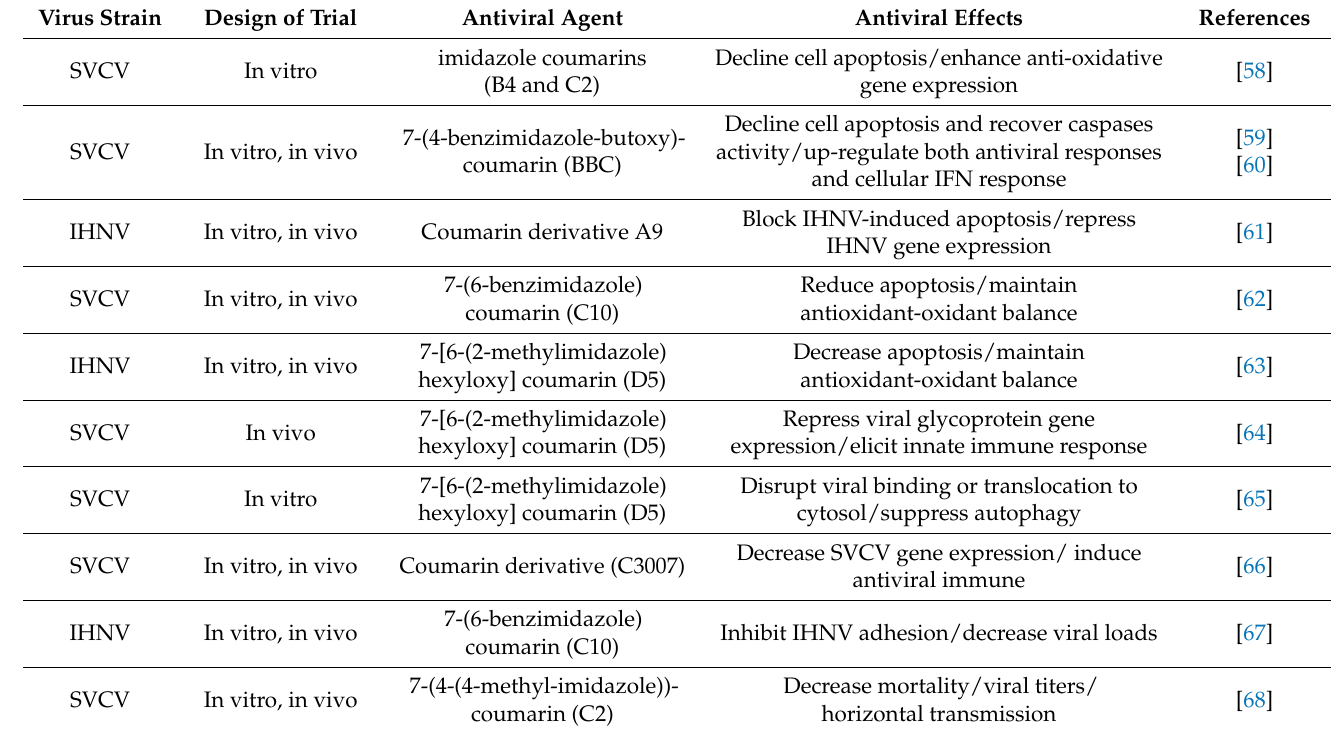
Table 5. Coumarin derivatives against fish rhabdoviruses and their antiviral